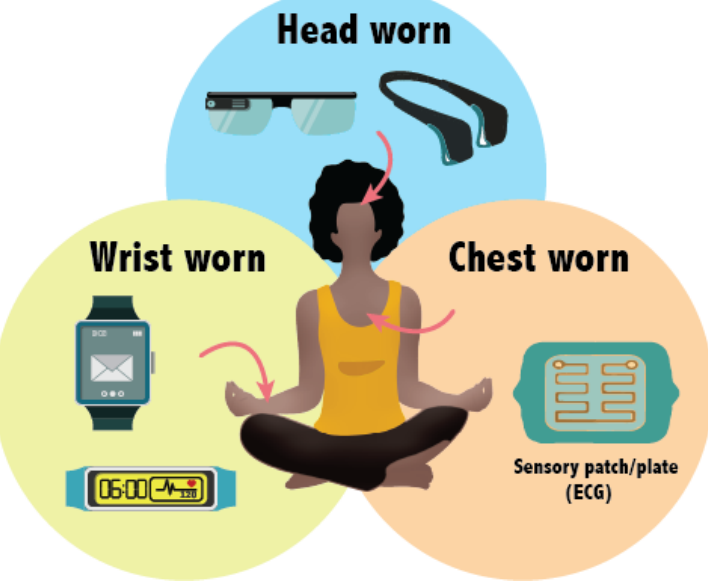
Figure 1. Classified wearable sensors for educational purposes according to three major categories according to their placement. They can be worn on the head, wrist or chest to collect and monitor information from students and